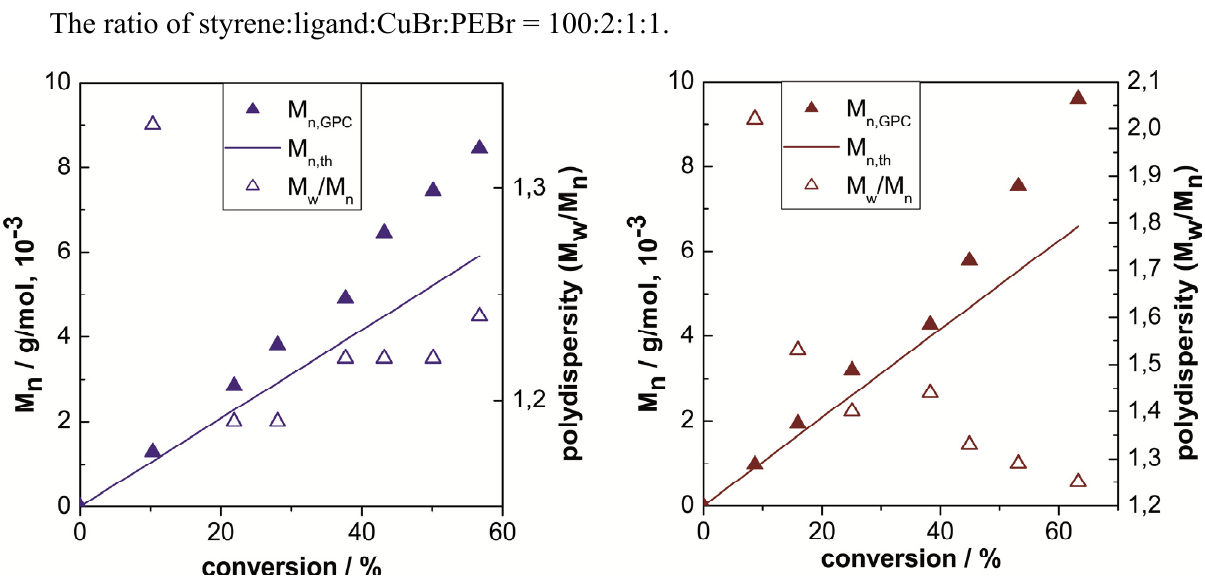
), the theoretical n,GPC